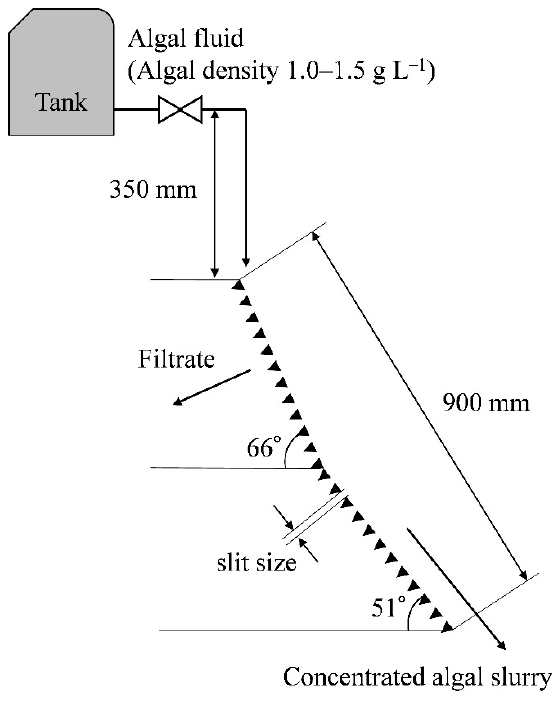
Figure 1. Side view of the inclined solid–liquid separator consisting of two wedge-wire screens at different angles.